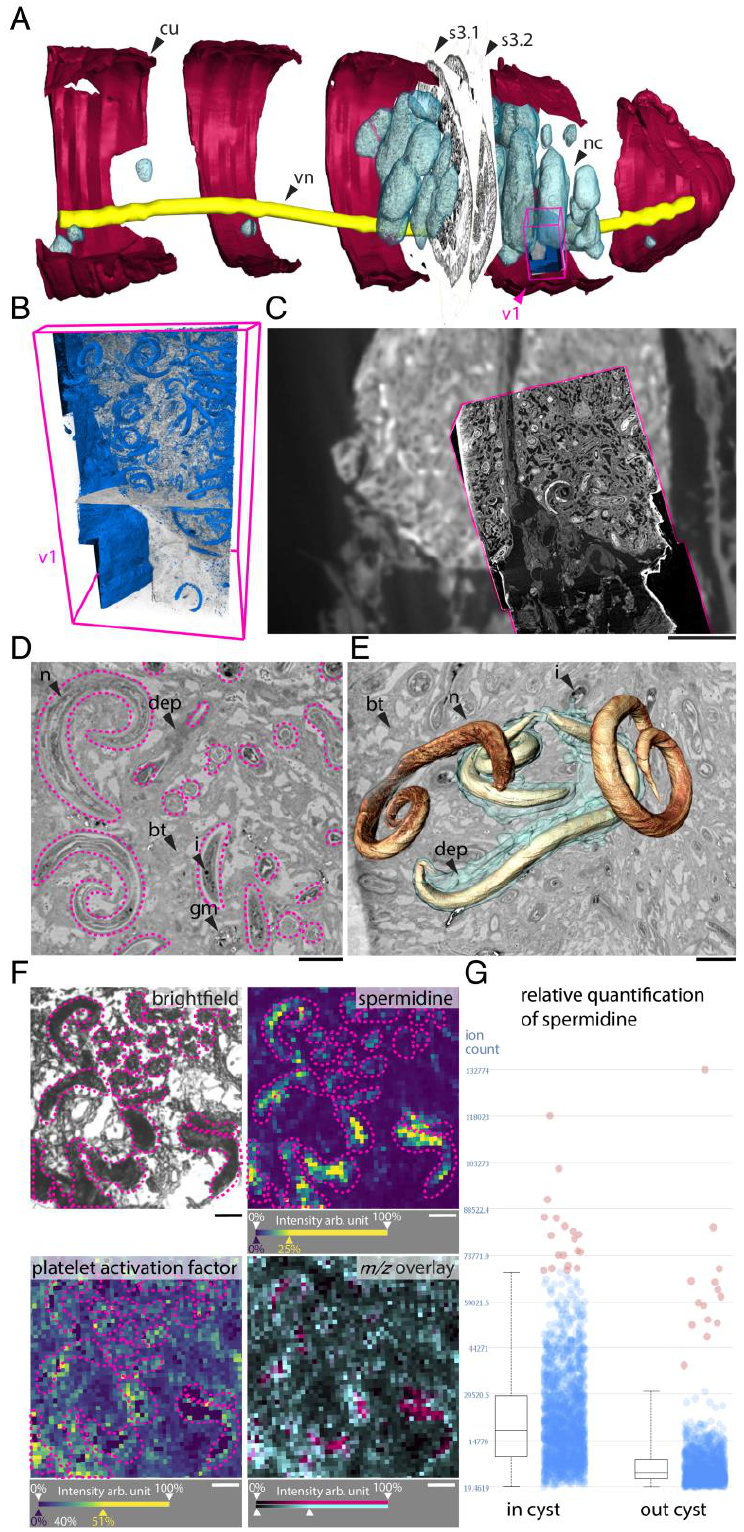
Figure 3. Using the 3D chemo-histo-tomography (CHEMIST) atlas to expose the interactions between adult earthworms ( L. rubellus ) and parasitic nematodes ( Rhabditis ). Figures were reproduced with permission from Geier and colleagues [105].